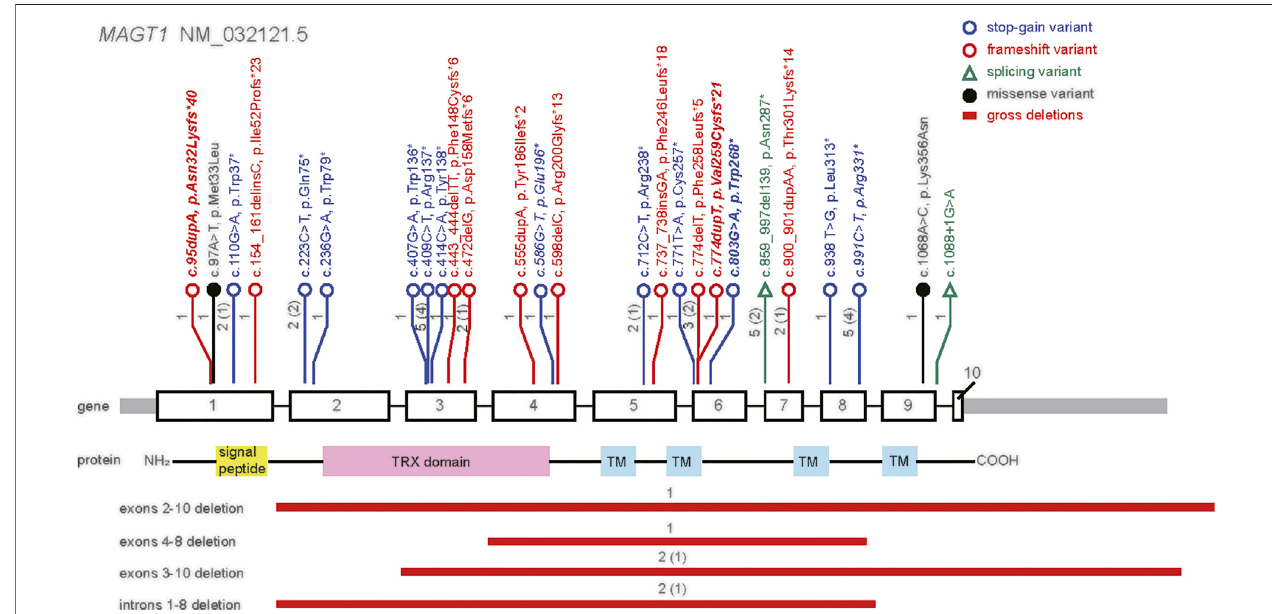
FIGURE 3 | Distribution of disease-causing variants in MAGT1 gene in previous literatures and the present study. MAGT1 protein consists of a signal peptide, a thioredoxin (TRX) domain and four transmembrane (TM) regions. Variants identi fi ed in this study are in italics, and novel variants are in bold. The number of patients carrying each variant is labeled with family numbers in round